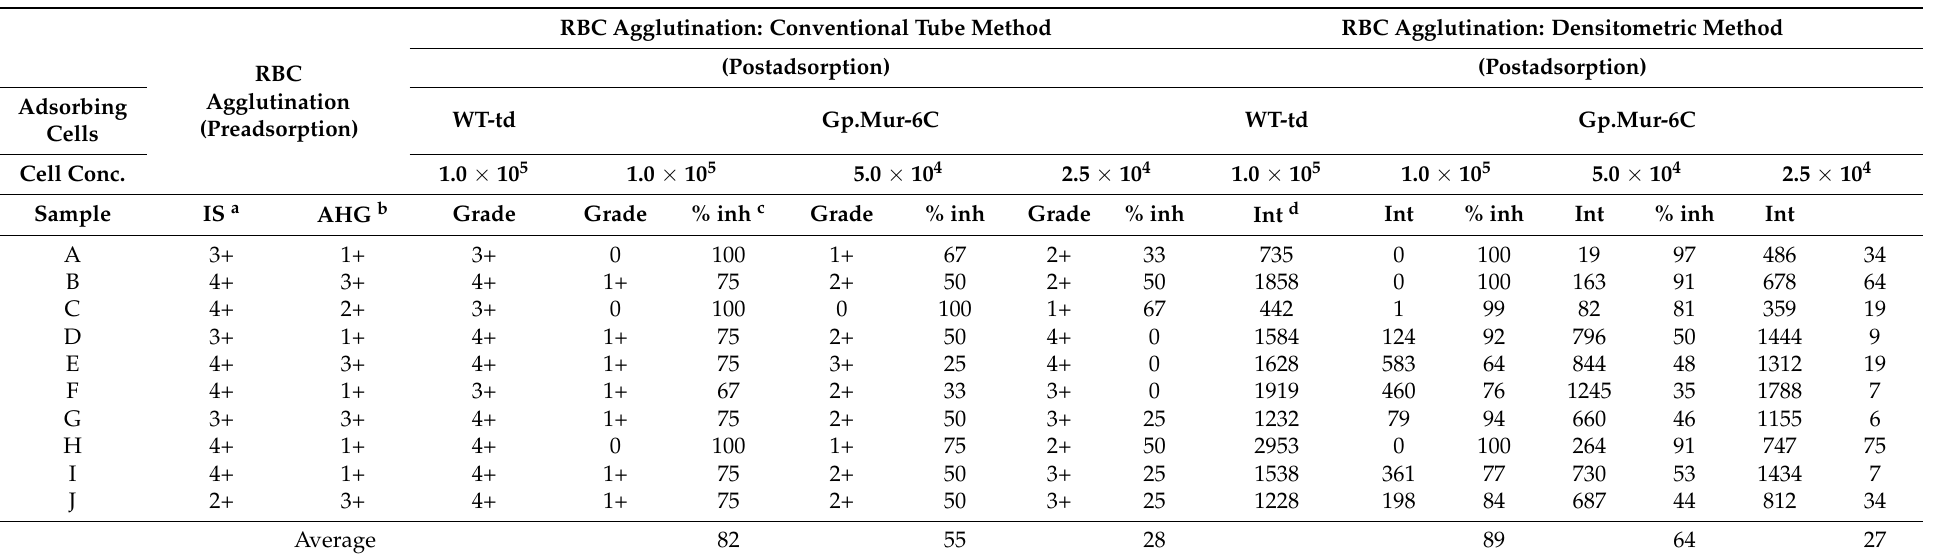
Table 1. Comparison of hemagglutination inhibition using different concentrations of cells displaying